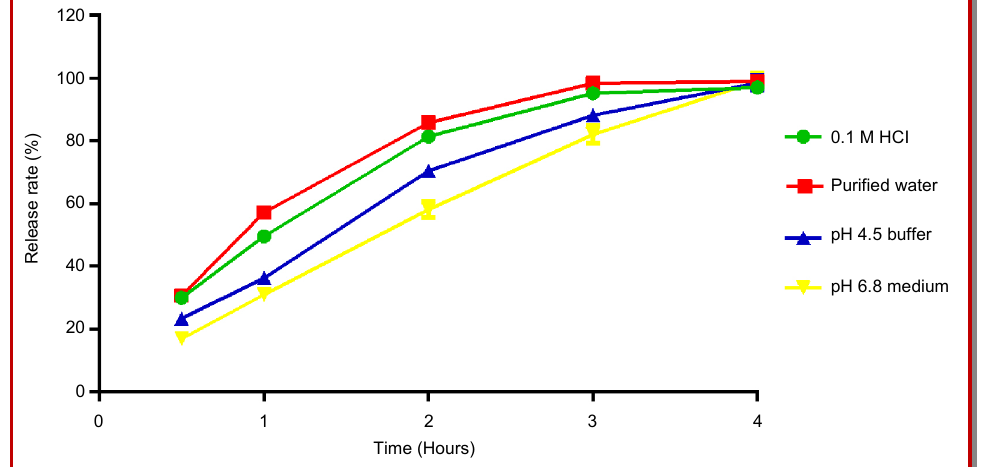
Figure 1: The release curves of the marketed reference sustained-release samples of different batches, with 0.1M HCl as the release medium at the rotation speed of 100 rpm